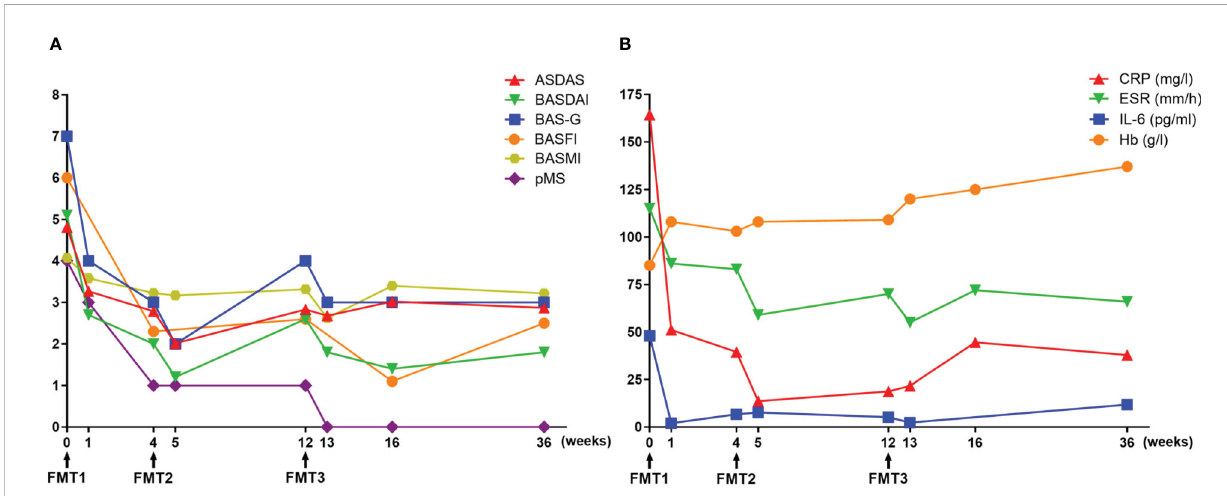
FIGURE 1 Therapeutic evaluation of fecal microbiota transplantation. (A) Clinical assessments of ankylosing spondylitis (AS) and ulcerative colitis (UC). (B) Laboratory fi ndings. ASDAS, AS Disease Activity Score; BASDAI, Bath AS Disease Activity Index; BAS-G, Bath AS Patient Global Score; BASFI, Bath AS Functional Index; BASMI, Bath AS Metrology Index; pMS, partial Mayo score; CRP, C-reactive protein; ESR, erythrocyte sedimentation rate; IL-6, interleukin-6; Hb,